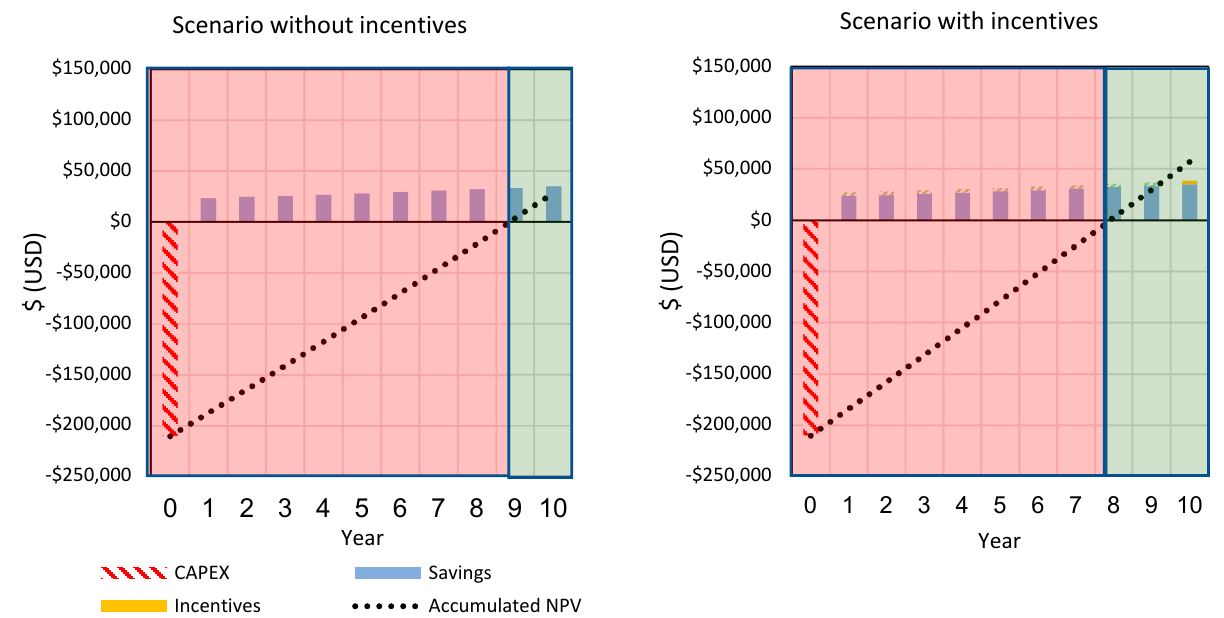
Figure 8. Cost − benefit scenarios for a project without ( left ) and with incentives ( right ) for renewable energy generation.